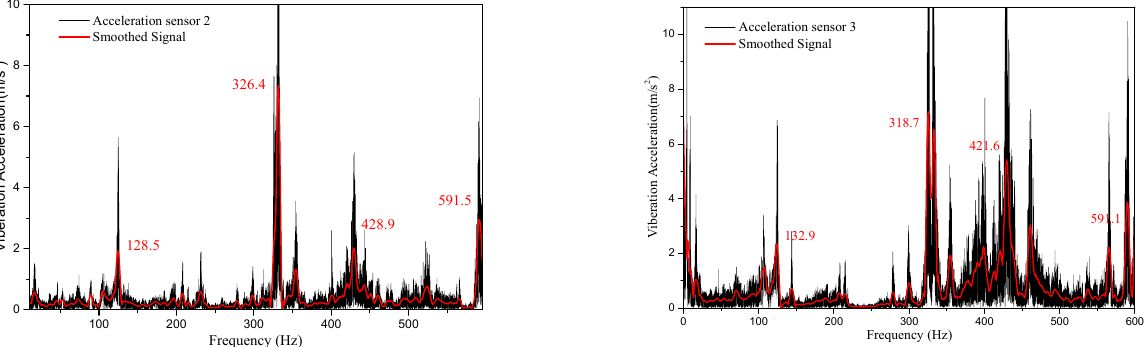
Figure 12. Acceleration amplitude-frequency characteristic curves at different positions of cylindrical shell structure.